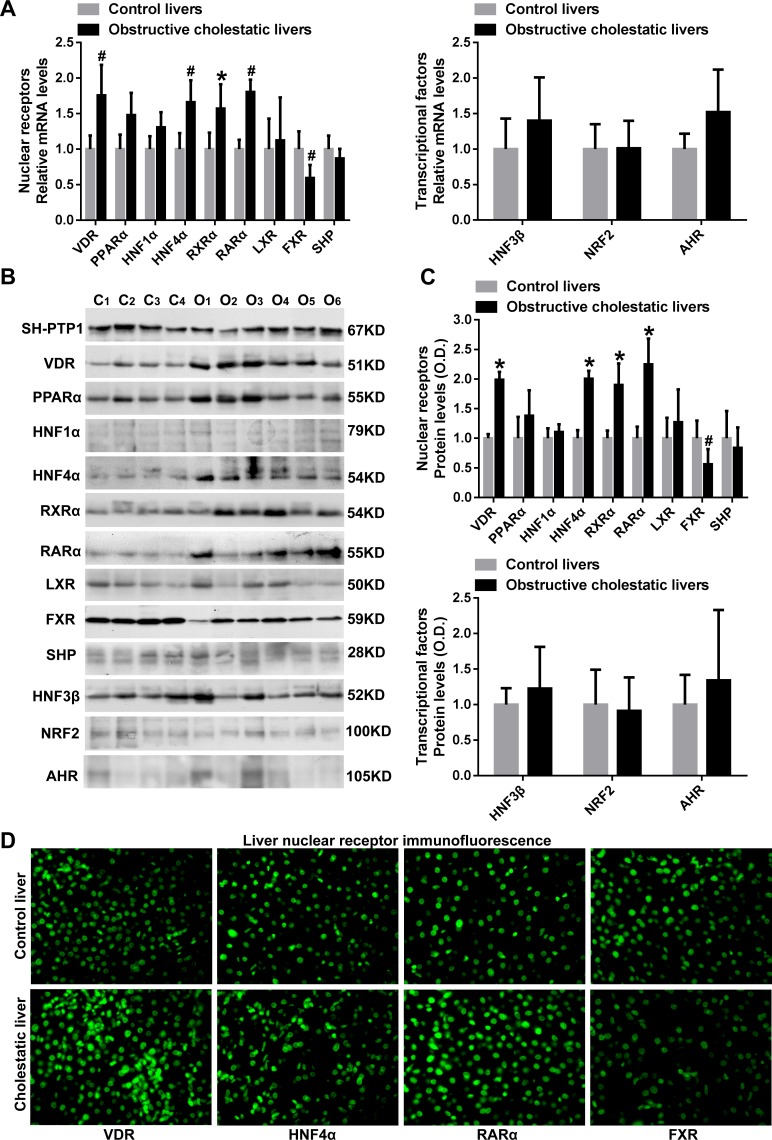
Nuclear receptors, VDR, HNF4α, RARα, and FXR levels in liver samples from patients with obstructive cholestasis.Real-time qPCR analysis of nuclear receptors mRNA levels (A) VDR, PPARα, HNF1α, HNF4α, RXRα, RARα, LXR, FXR, and SHP, and transcriptional factors HNF3β, NRF2 and AHR (n = 22 for each group). (B) Representative western blot for VDR, PPARα, HNF1α, HNF4α, RXRα, RARα, LXR, FXR, SHP, and HNF3β, NRF2 and AHR and (C) their corresponding densitometry (% of control group, n = 22 for each group). (D) IF labeling of VDR, HNF4α, RARα, and FXR protein (green) in the liver of patients with obstructive cholestasis and controls. C, controls; O, obstructive cholestasis liver samples. *p < 0.01; #
p <0.05 versus controls.